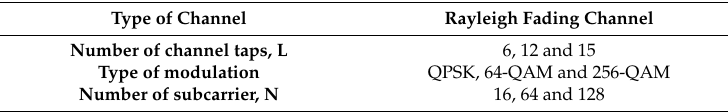
Table 1. Simulation parameters.